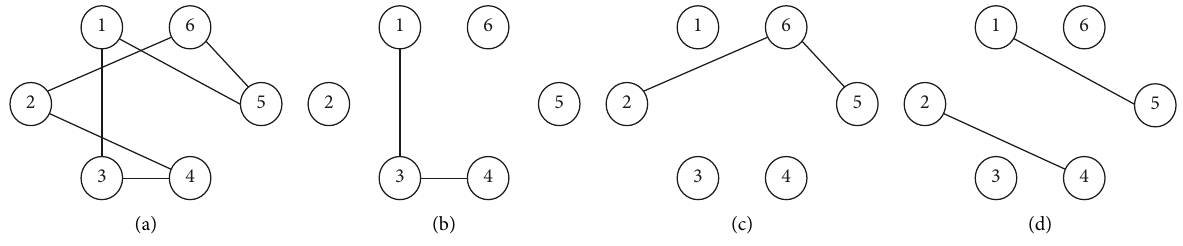
Figure 4: The switching topologies of Example 2. (a) G . (b) G 1 . (c) G 2 . (d) G 3 .